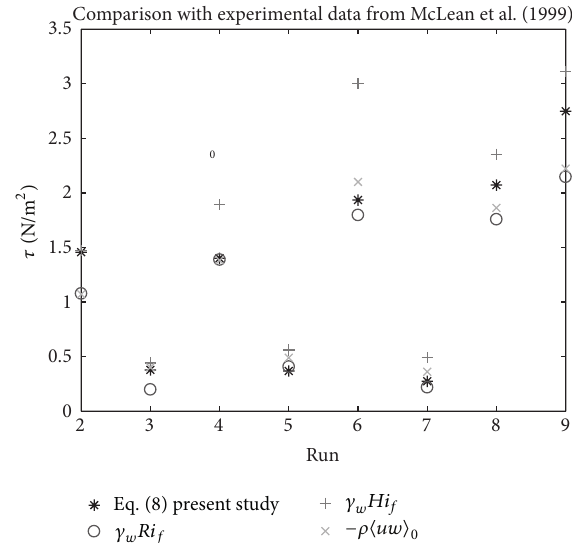
Figure 5: Behaviour of the calculated friction factor as a function of Froude number.